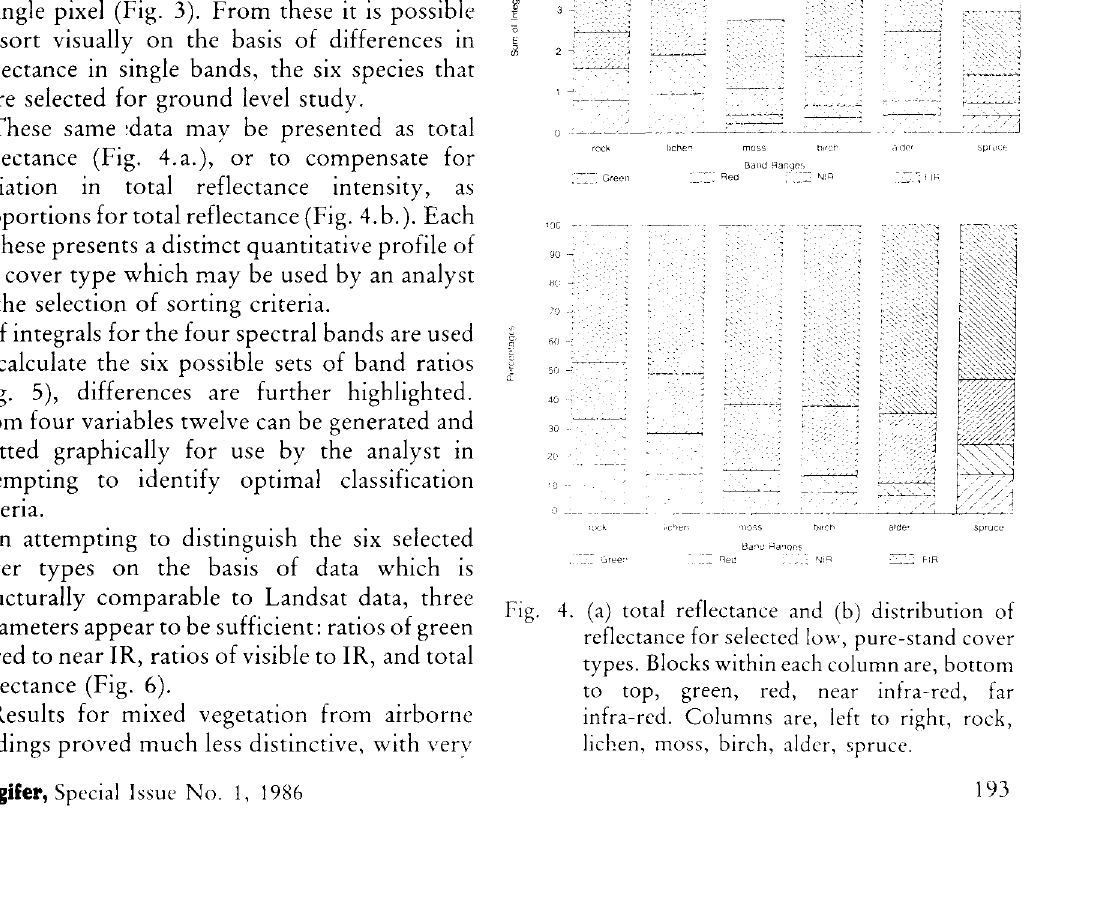
Fig. 3. Integrals for Landsat bands for selected low, pure-stand cover types. Columns within each block are, left to right, green, red, near infra-red, far infra-red. Blocks are, left to right, rock, lichen, moss, birch, alder, spruce.